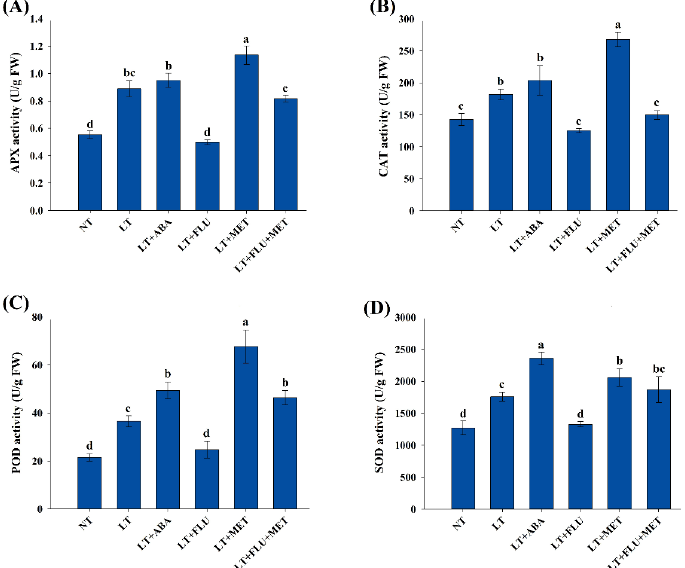
Figure 7. Effects of exogenous melatonin and ABA on the activities of antioxidant enzyme (APX ( A ), CAT ( B ), POD ( C ), and SOD ( D )) in strawberry seedlings under cold stress. Plants treated with distilled water under the normal conditions (25 °C) served as control (NT). The strawberry seedlings were pretreated with distilled water (LT), 100 μ M ABA (LT + ABA), 50 μ M fluridone (LT + FLU), 100 μ M melatonin (LT + MET), and 50 μ M fluridone + 100 μ M melatonin (LT + FLU + MET) 3 times in a two ‐ day interval and then exposed to cold stress for 2 days. Graphs represent the mean of three biological replicates. Values labeled with different letters indicate significant differences among treatments at ( p ≤ 0.05) by LSD.